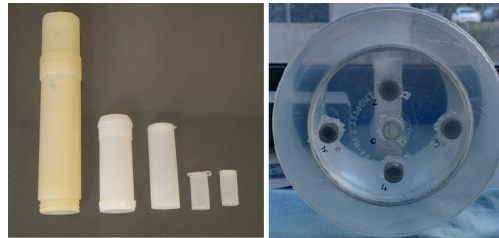
Fig. 7. (left) the specimen capsules for irradiation in PTS and RG, (right) device used for irradiation of dosimeters in the NB1 channel.